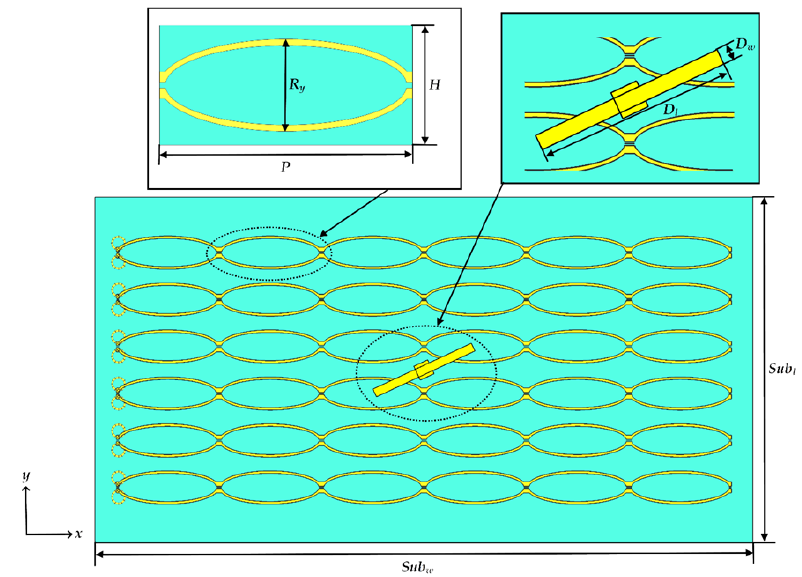
Figure 2. Top view of the antenna.